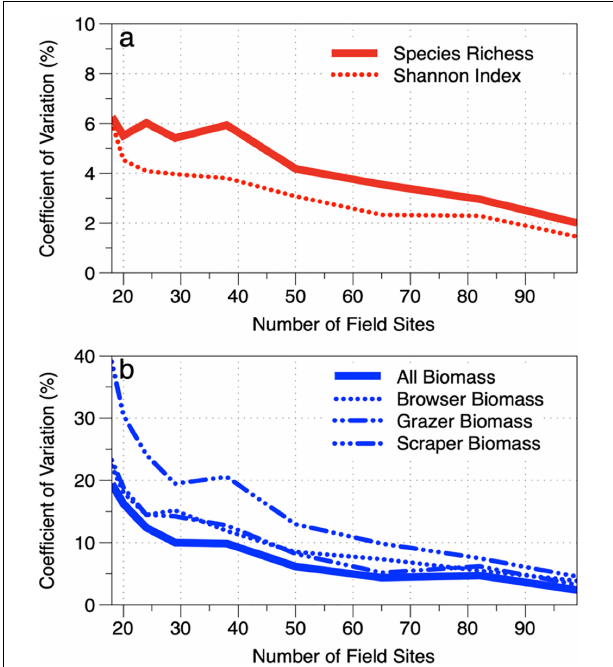
FIGURE 10 | Reduction in bootstrap coefficient of variation (CV) while increasing the number field sites used in the stratum-level mean estimates of (a) fish species diversity and (b) fish biomass values under the stratified-random sampling scheme. These trends indicate our ability to capture the true mean value of each of the 18 strata using field